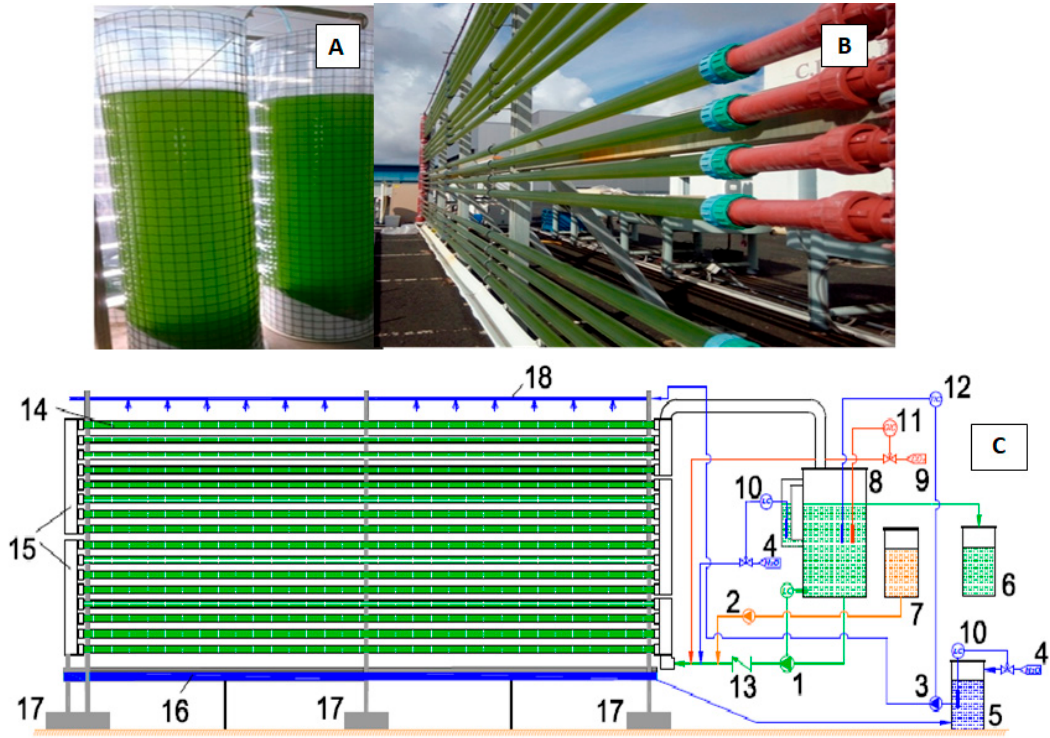
Figure 1. Cultivation systems for large-scale production of Coccomyxa onubensis biomass. Indoor